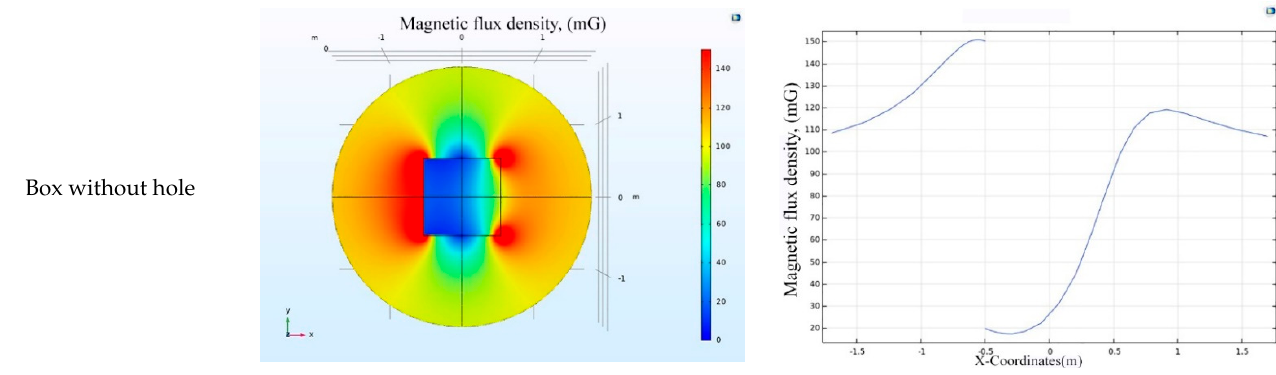
Table 6. Comparison between magnetic fields for different hole patterns. Magnetic Field (mG)